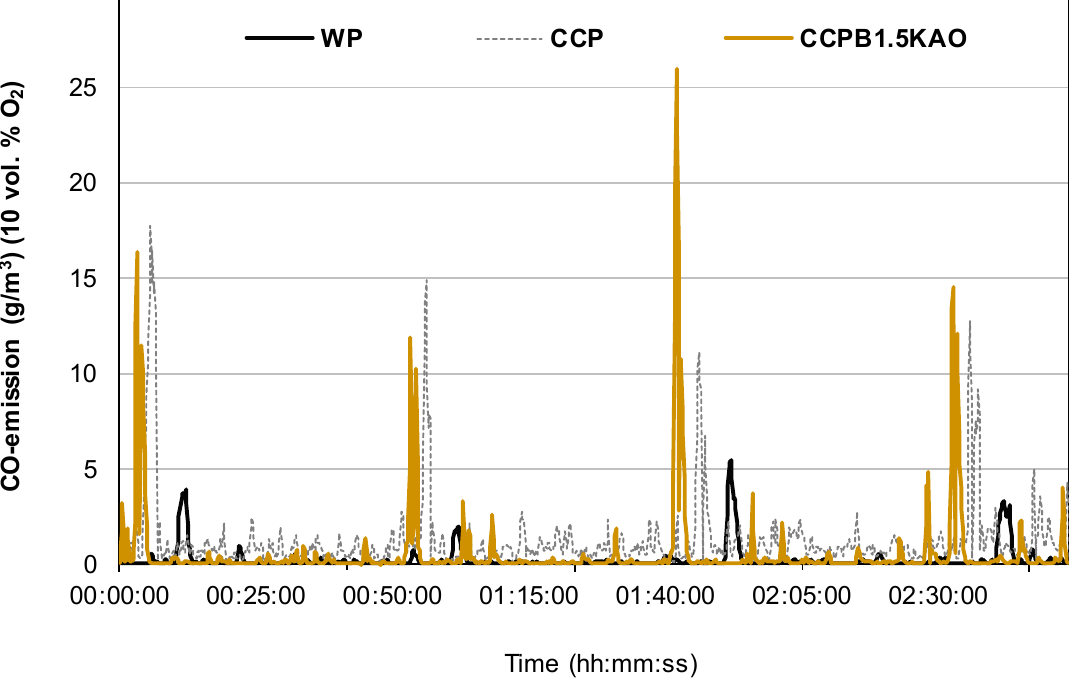
Figure 4. Carbon monoxide (CO-) and total particulate matter (TPM-) emissions (for experimental list see Table 2).